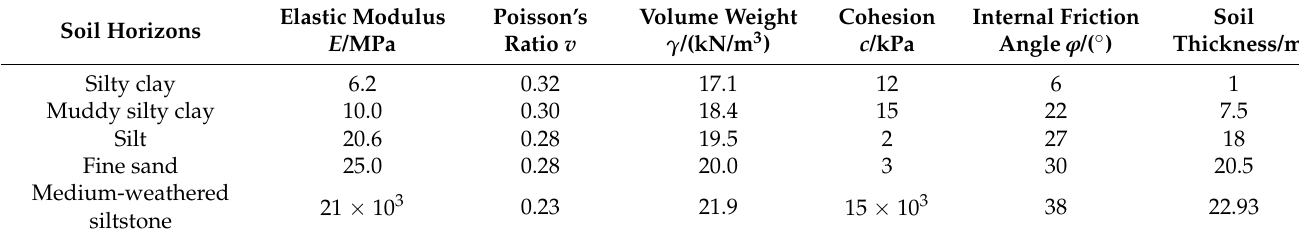
Table 1. Physical and mechanical parameters of the in situ soil.